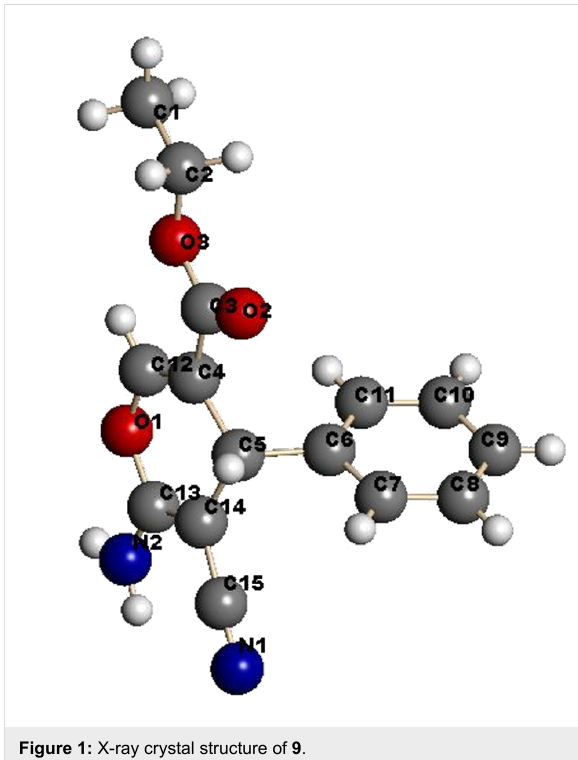
Figure 1: X-ray crystal structure of 9